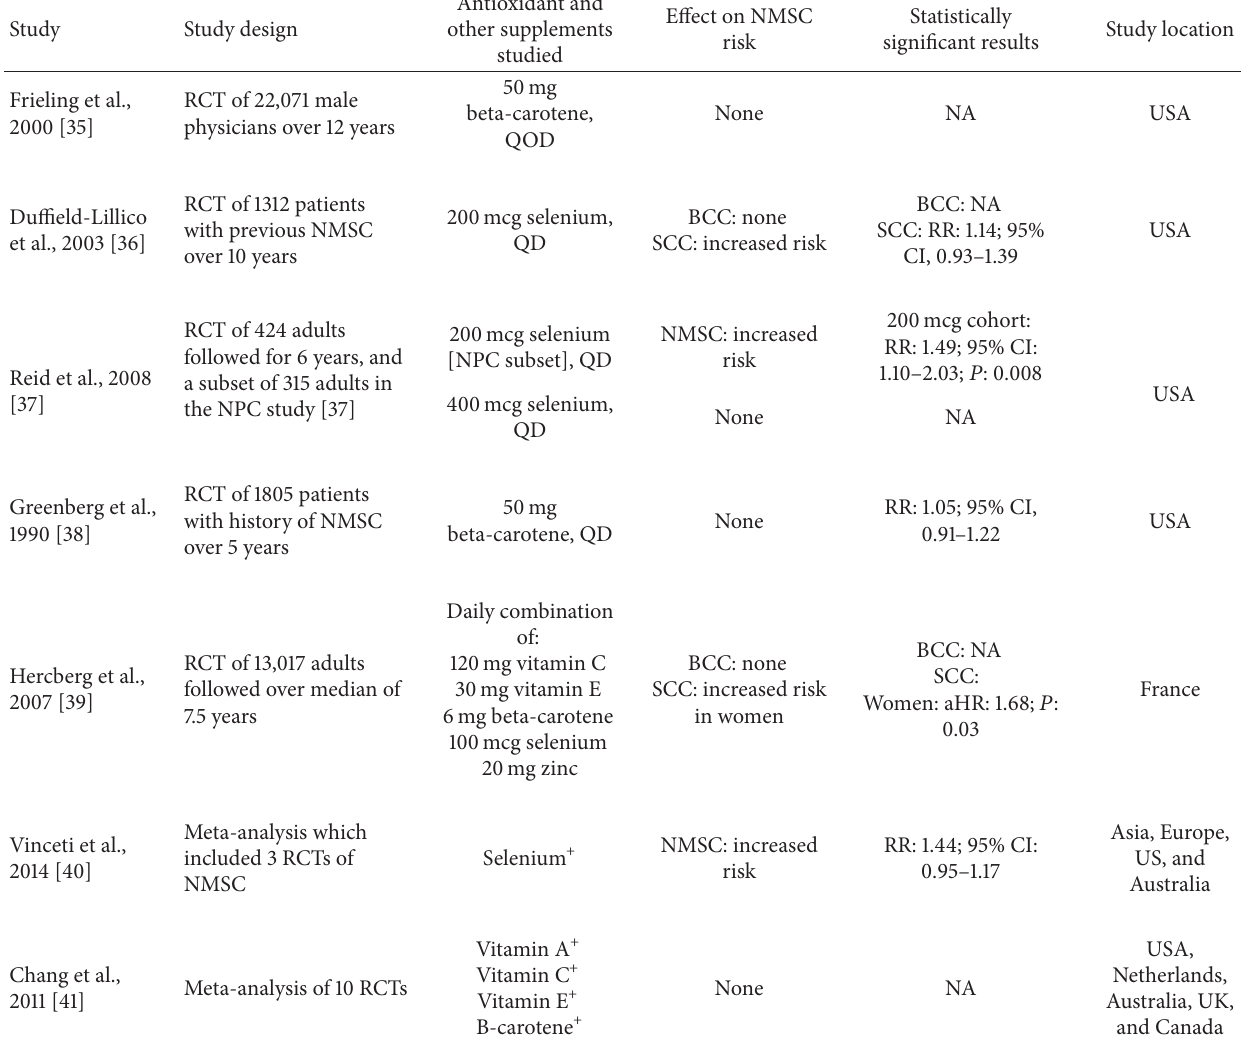
Table 1: Experimental studies of AO supplements and NMSC incidence in human